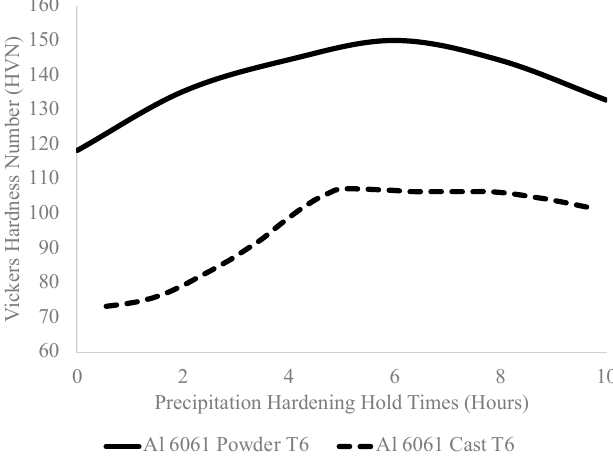
Figure 13. Al 6061 T6 curves associated with powder and a cast system from literature [61].